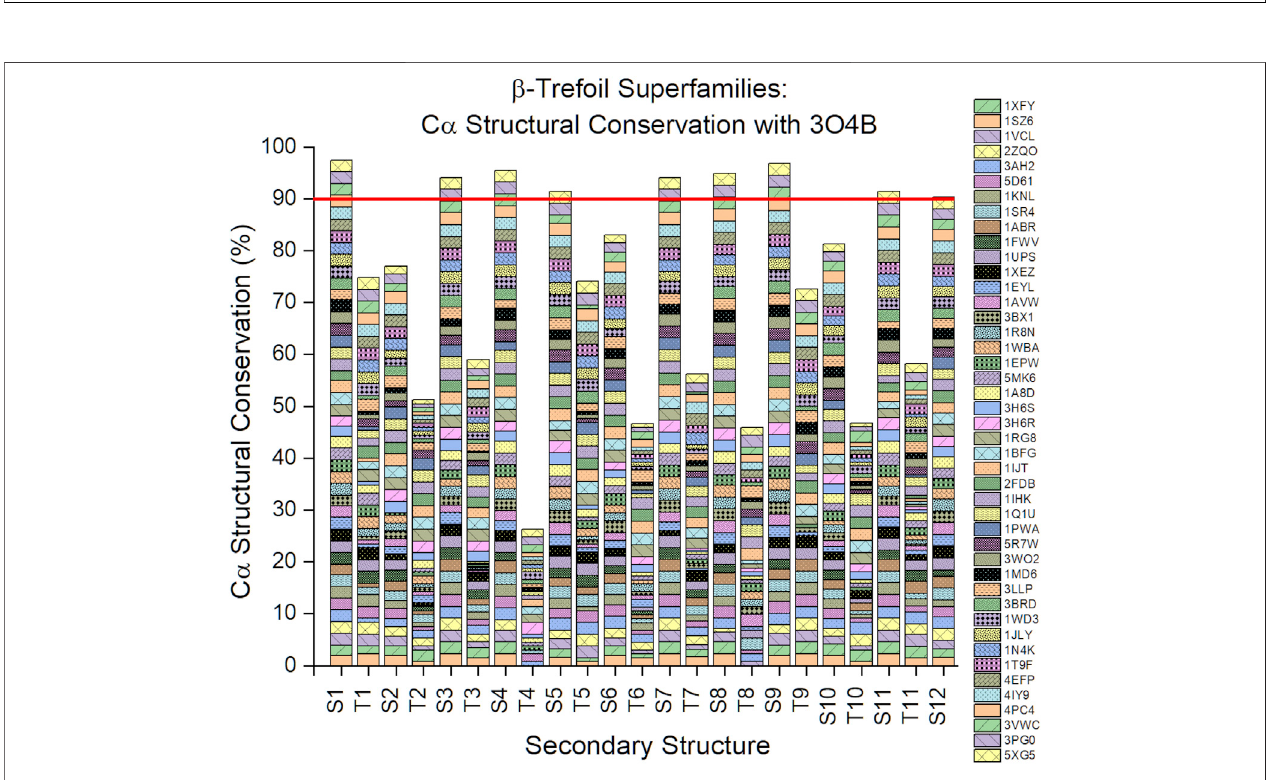
FIGURE 4 | C α structural conservation ( < 1.5 Å rmsd) within secondary structure elements for the β -trefoil family of proteins. The reference protein is the Symfoil protein (RCSB 3O4B) — a de novo designed, purely-symmetric, minimalist, and functionless β -trefoil protein (see Figure 1 ).